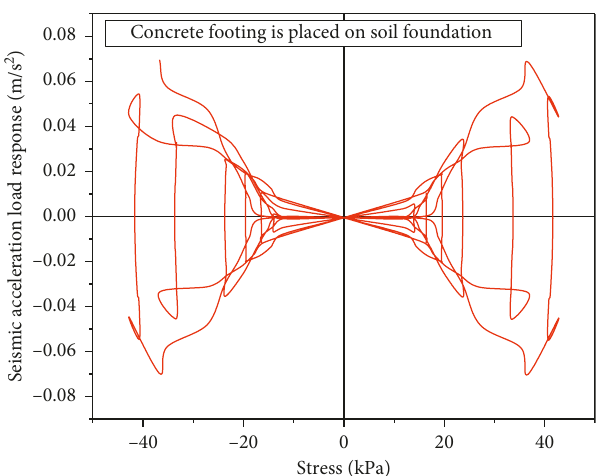
Figure 15: Seismic acceleration load response vs stress at the base of a concrete footing, during concrete footing-soil foundation interaction.